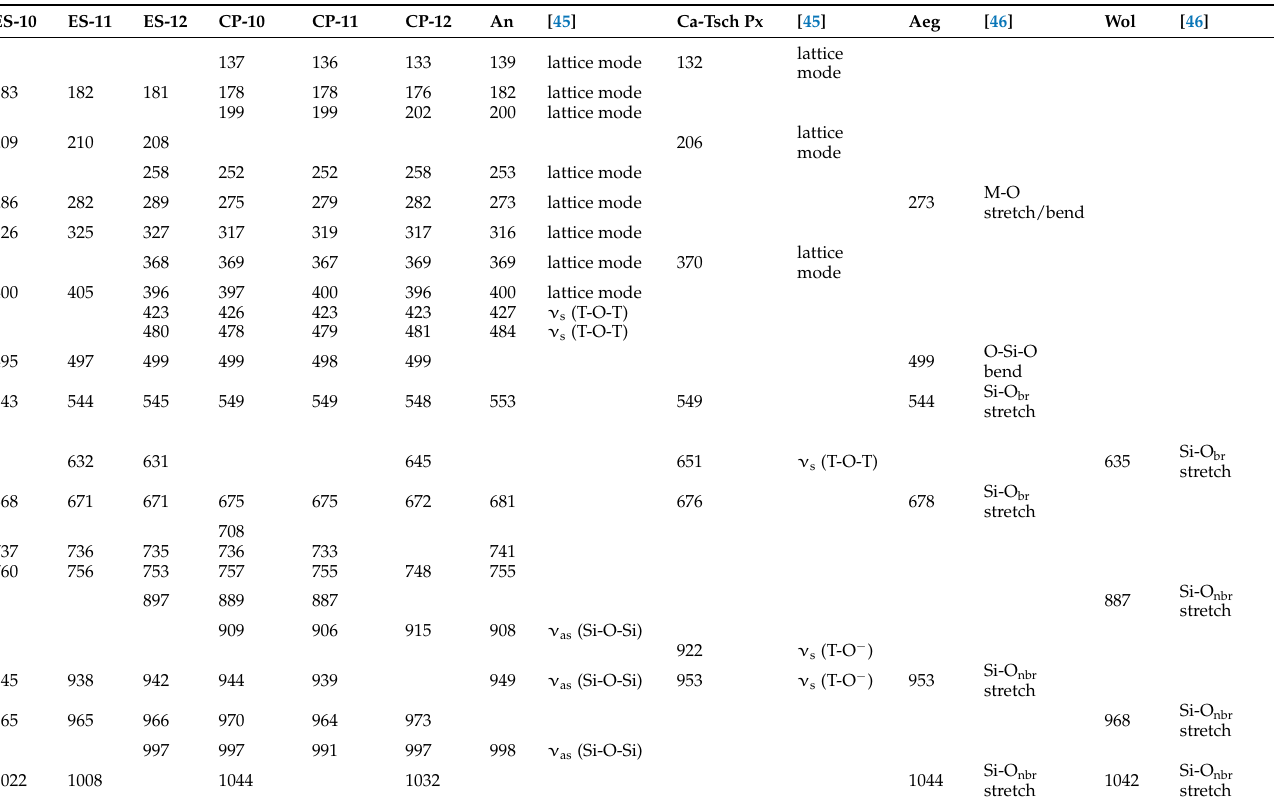
Table 8. Assignment of breakdown products bands in the Raman spectra of studied samples compared to anorthite (An), Ca-tschermakitic pyroxene (Ca-Tsch Px), aegirine (Aeg), and wollastonite (Wol).